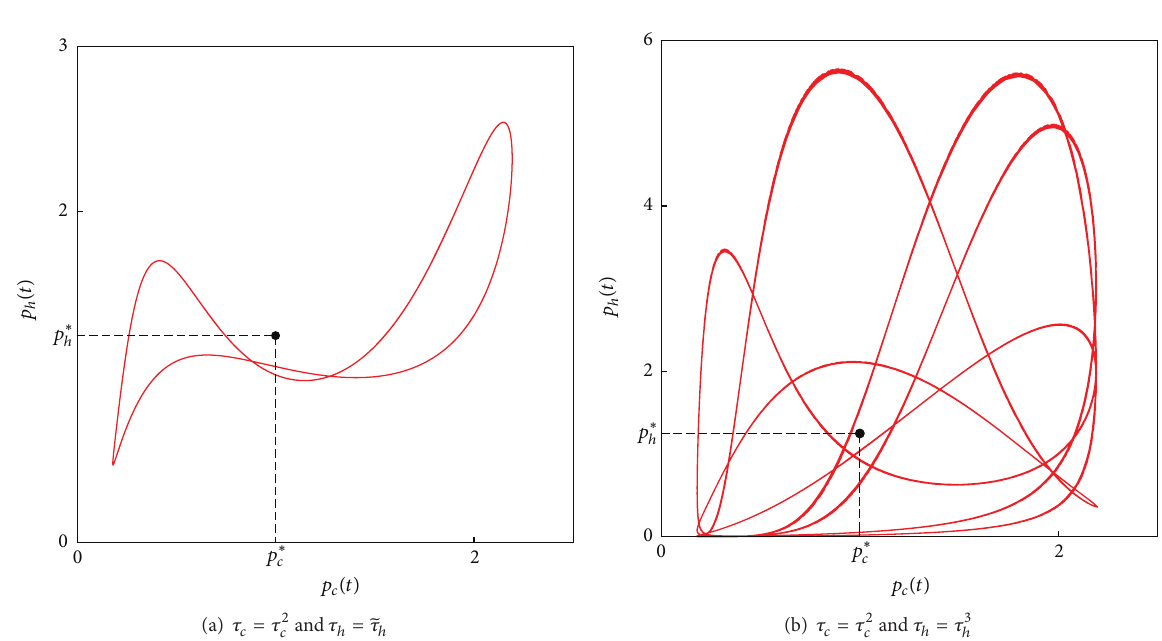
Figure 6: Phase diagrams at points 𝐴 and 𝐵